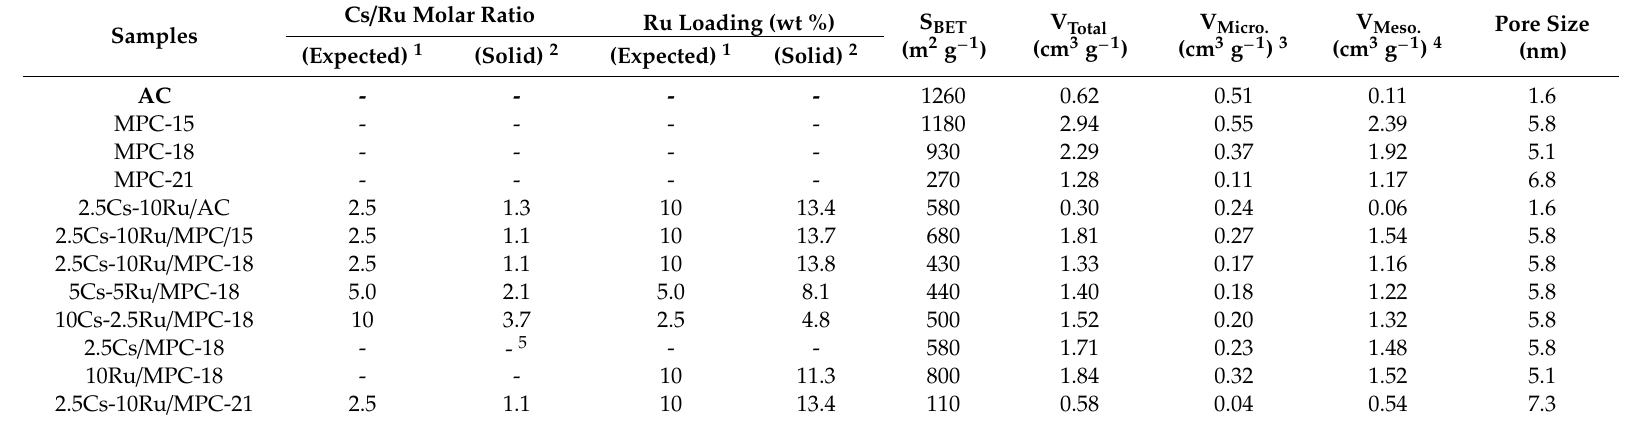
Table 1. Structural properties of carbon materials and the as-prepared Cs-Ru